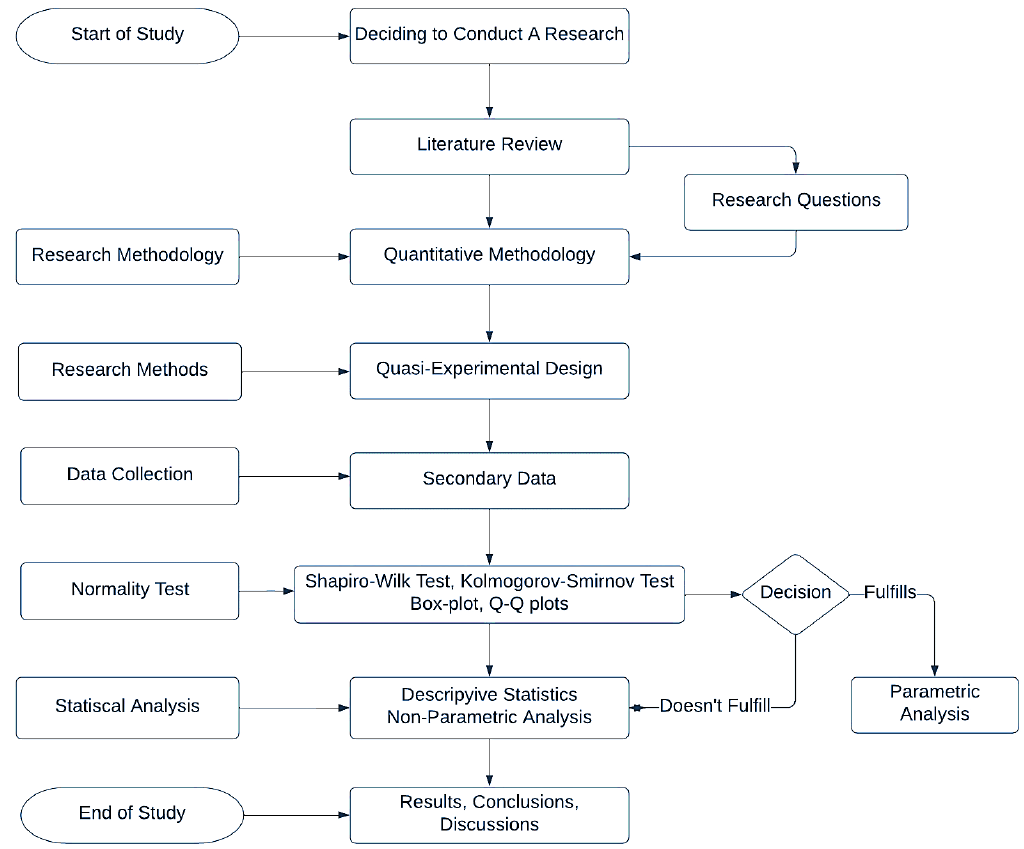
Figure 1. Research methodology